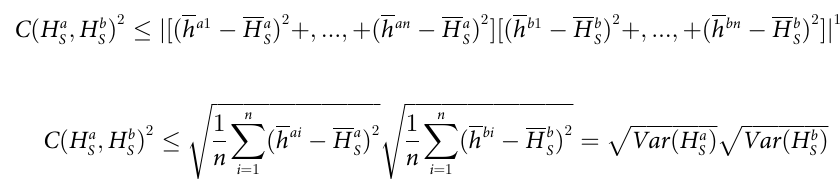
ffiffiffiffiffiffiffiffiffiffiffiffiffiffiffiffiffi p ffiffiffiffiffiffiffiffiffiffiffiffiffiffiffiffiffi Þ Þ Var ð H a Var ð H b S S